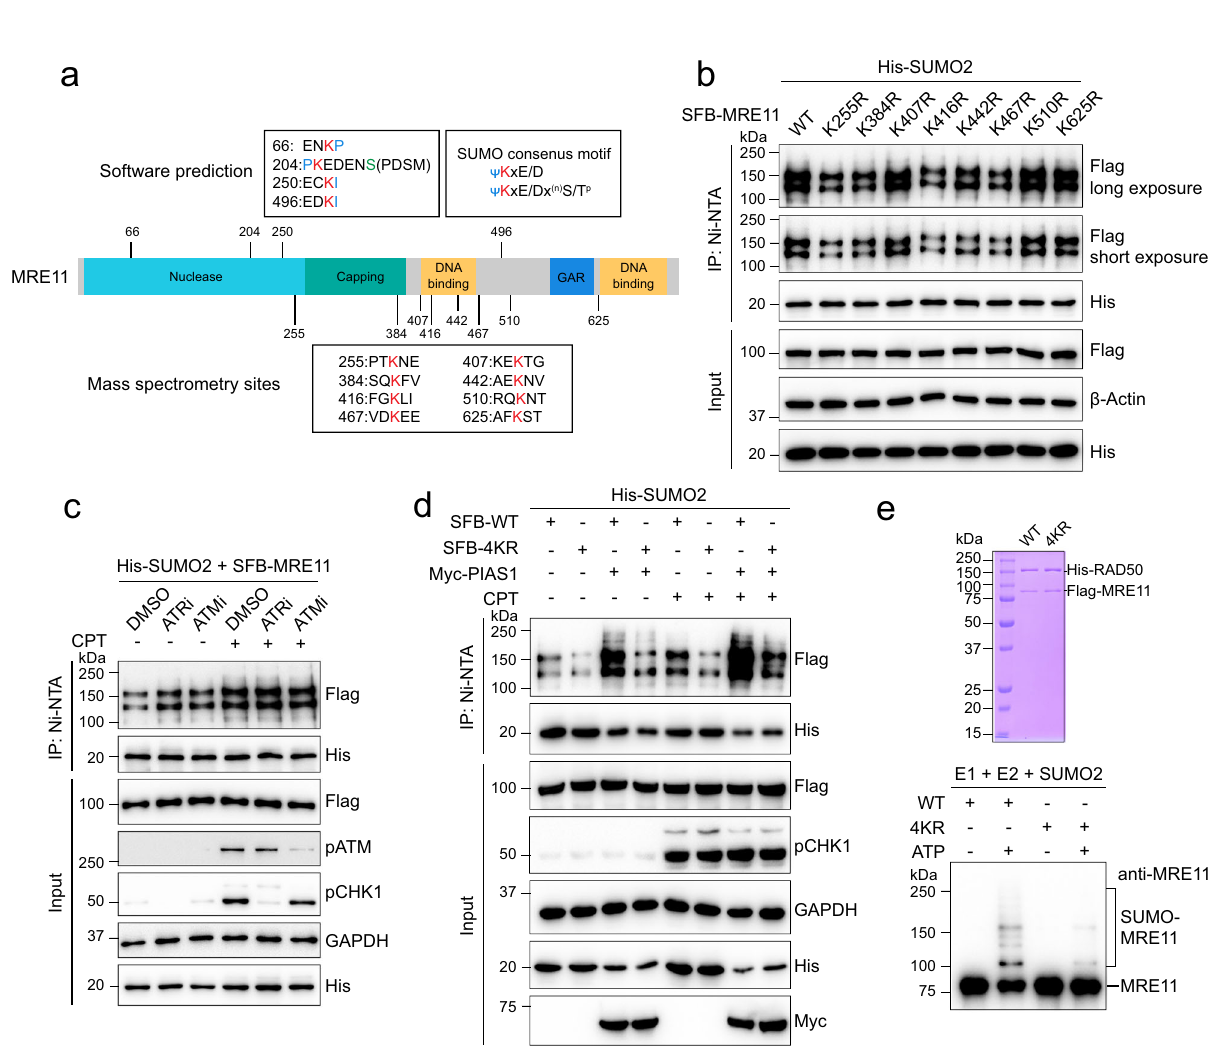
Fig. 3 | Screening for MRE11 SUMOylationsites. a Schematicof the SUMOylation sites in MRE11. The predicted high-rank sites analyzed by JASSA, SUMOplot, and GPS-SUMO software, and the mass spectrometry sites from a previous study were listed. b K255, K384, K416, and K467 mutations impaired MRE11 SUMOylation. HEK293T cells were transfected with His-SUMO2 and SFB-WT MRE11 or the indi- cated single point mutants, and then MRE11 SUMOylation levels were analyzed by